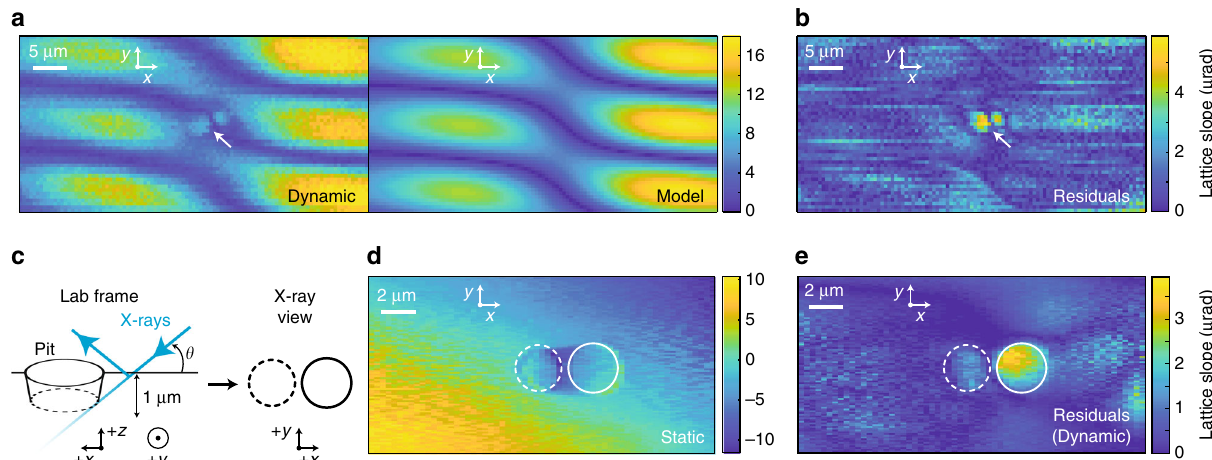
Fig. 4 Near structural defect dynamic curvature measured via s-SXDM. a Real-space map of the measured diffraction oscillation amplitude, a white arrow show presence of the fabricated pit in the SiC surface. The expected instantaneous curvature is predicted with a simple phenomenological model including Gaussian focusing and wave periodicity as free parameters. The weak S-shaped connection of the bimodal transverse curvature originates from a small (~2 degree) misalignment of the diffraction plane to the wave propagation direction. b The best fi t of the model parameters were then used to subtract the curvature of the unperturbed SAW, allowing visualization of a locally trapped high amplitude wave near the pit (arrow). The spatial step size in a and b is 500nm, with a 25nm spot size. c SXDM sketch of the fabricated structural defect with a scattering angle θ = 18 degrees. The surface coordinate scanning in the x – z plane is corrected for sample angle relative to X-ray beam. d Nanoscale imaging near the pit of static strain, or lattice curvature, from the mean x centroid shift. e Dynamic transverse curvature residuals from the rms x centroid shift during stroboscopic imaging with a theoretical SAW model subtracted. A solid and dashed circle represent the upper and lower edges of the pit for reference. The spatial step size in d and e is 50nm, with a 25nm